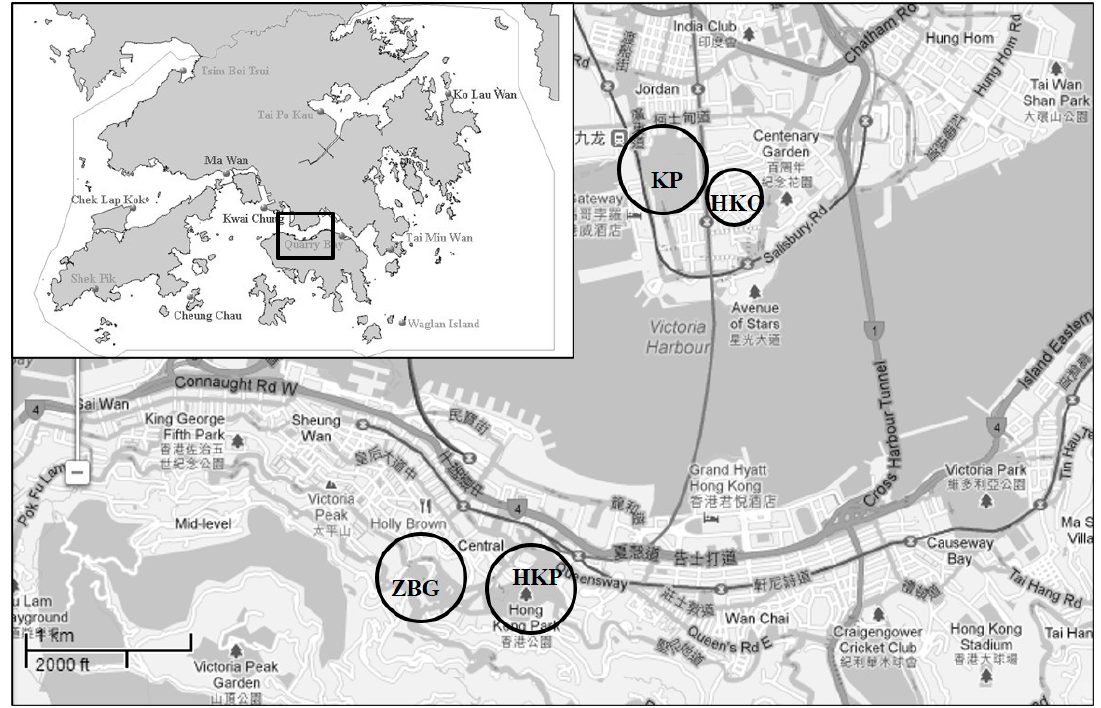
Figure 1. A map of Hong Kong and locations of the four parks, Hong Kong Park (HKP), Hong Kong Zoological and Botanical Garden (ZBG), Kowloon Park (KP), and Hong Kong Observatory Grounds (HKO) sampled in this study. (http://www.hko.gov.hk/tide/marine/hko.htm, https://maps.google.com.hk/).